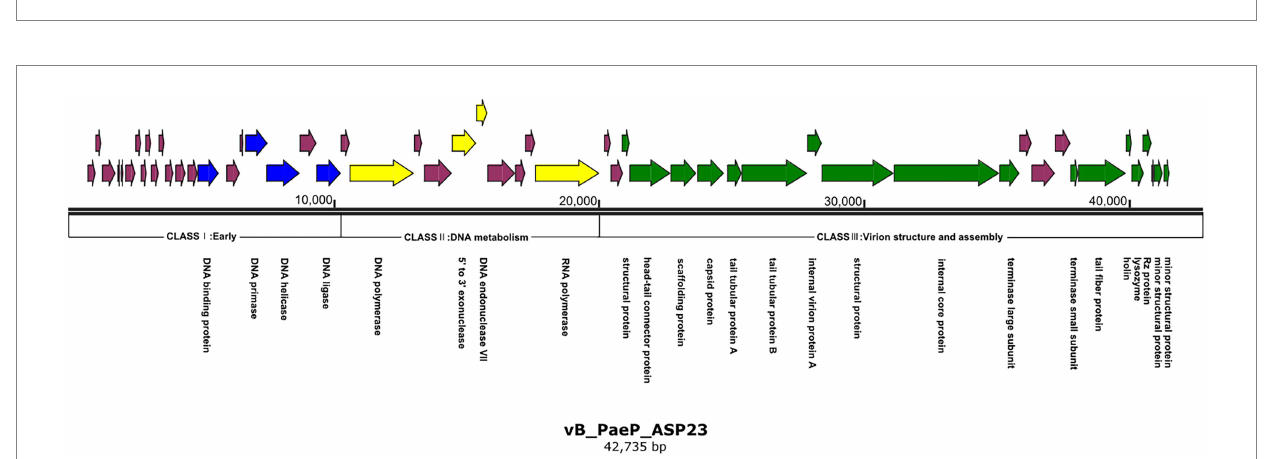
FIGURE 2 Bacterial counts in two tissues and blood of minks treated with phage ASP23 after they were challenged with P. aeruginosa L64 for 2 h. (A) liver, (B) lung, and (C) blood. Data are expressed as mean ± SD ( n = 3). * p < 0.05, ** p < 0.01.